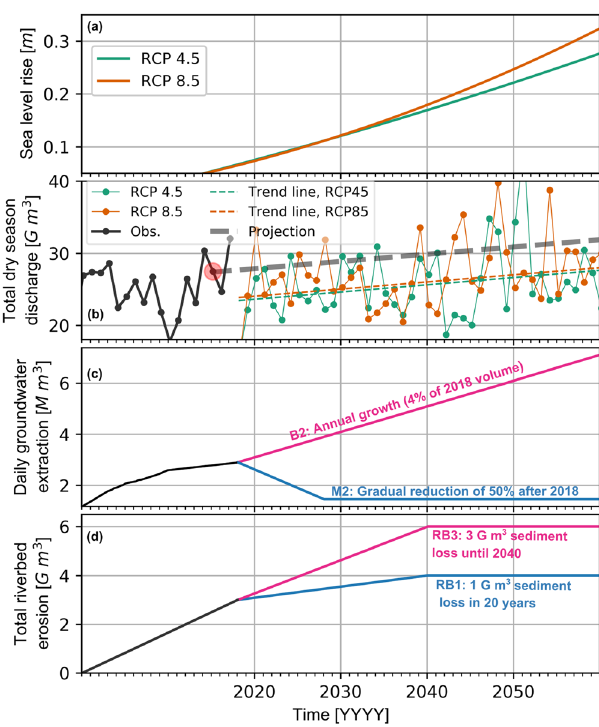
Fig. 2 Environmental drivers of saline water intrusion in the Mekong Delta. Future projections of driving forces of SWI; climate change-driven sea level rise ( a ) and discharge variation ( b ); scenarios of groundwater extraction ( c ) and scenarios of sediment loss from the riverbeds ( d